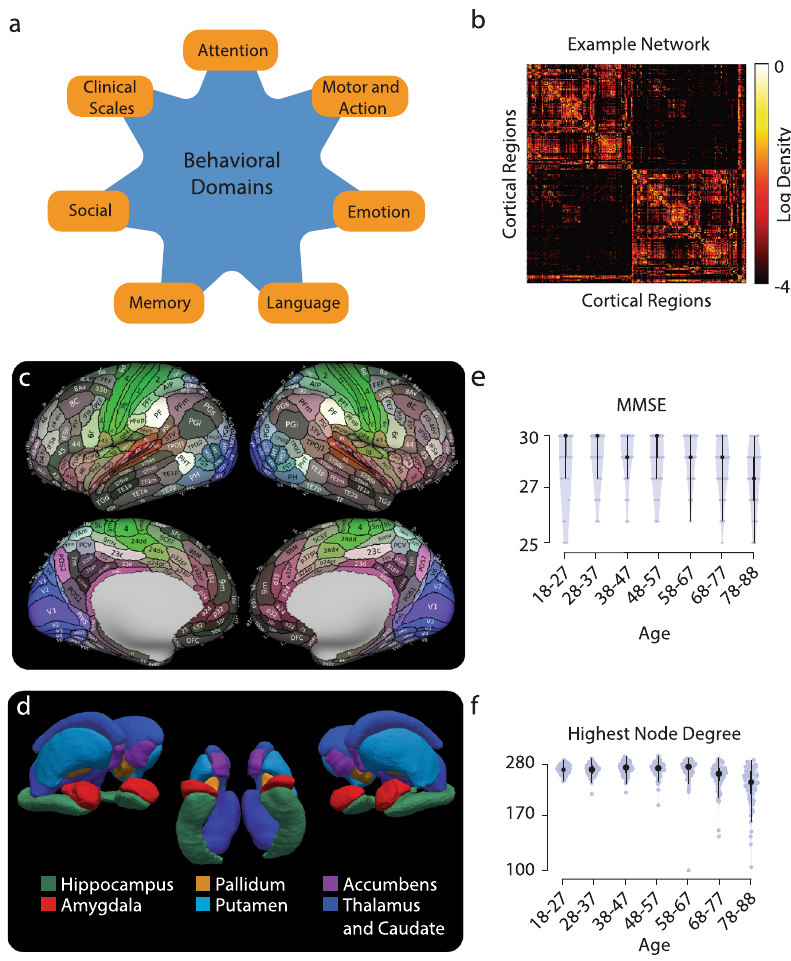
Fig. 1 Main fi ndings. a The behavioral domains. A simple graphic displaying the different behavioral domain labels is displayed. b An example network. This is an example of an individual ’ s network that is created for analysis. Each row and column represents a cortical region while the color represents the log scale of the density of the connection between nodes (weaker connections are black, stronger connections are yellow). c The cortical regions used to create the network structures. This fi gure, taken from Glasser et al. 94 , represents the cortical labels used to construct the network in ( b ). d Additional subcortical labels. A surface rendering of the subcortical labels that were estimated and added to the cortical labels is shown. e Trends in behavior over the lifespan. Violin plots show the full distribution of the observations for the Mini-Mental State Exam (MMSE). Error bars represent mean ± 2 standard errors (s.e.). f Trends in the connectome over the lifespan. Violin plots show the full distribution of the observations for the highest node degree. Error bars represent mean ± 2 s.e. For panels e and f , subjects were binned by decades starting at 18 years of age (see ref. 90 ).